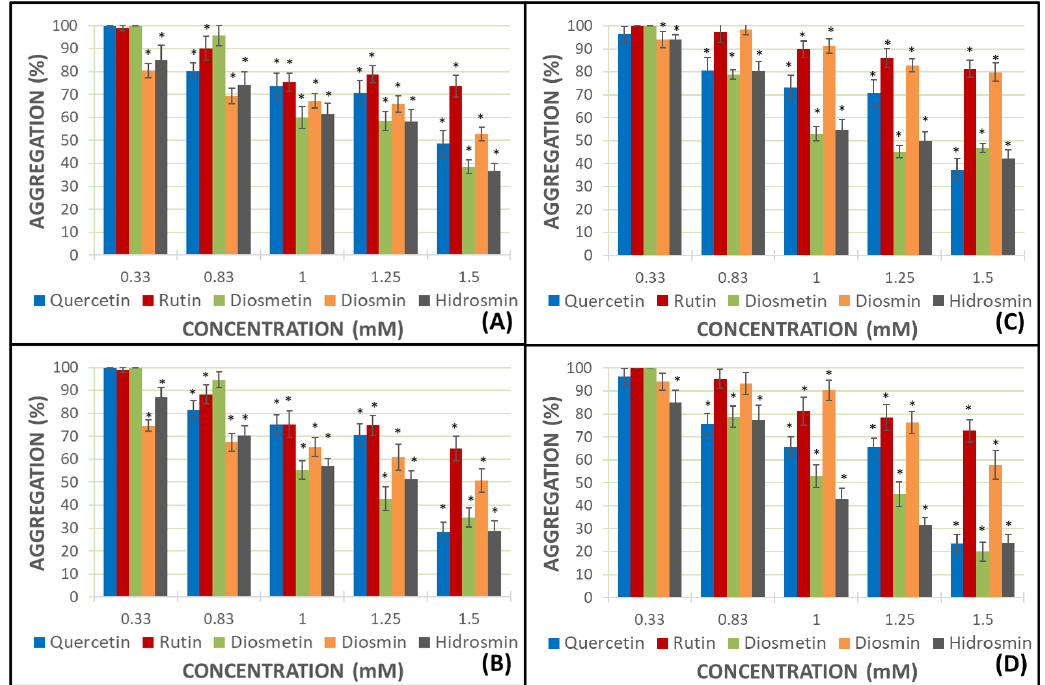
Figure 2. Platelet aggregation generated in the presence of each flavonoid in WB samples with ADP and AA (( A ) and ( B ) panels, respectively), and in PRP samples with ADP and AA (( C ) and ( D ) panels, respectively). Error bars indicate the standard deviation. Color bars describe the mean and standard deviation for N = 8. * p < 0.05: statistically significant variations in platelet aggregation between samples with and without the assayed flavonoid.